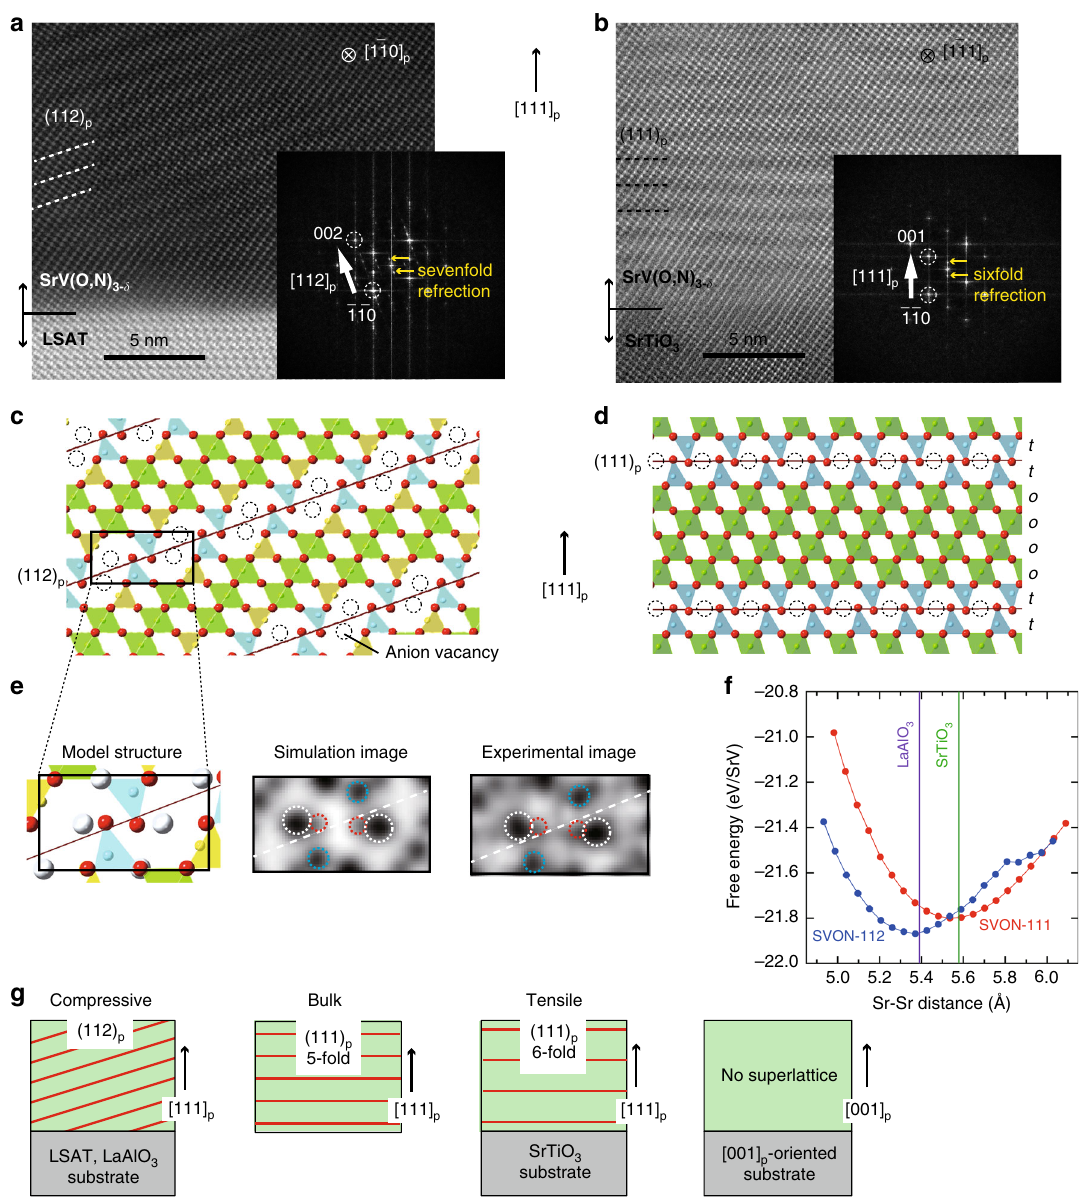
Fig. 4 Strain-induced switching of anion-vacancy layers in [111]-oriented oxynitride thin fi lms. a , b Cross-sectional HAADF image of the nitridized SrVO 3 fi lm on a LSAT (111) and b SrTiO 3 (111) interfaces taken along ½ 1 (cid:1) 10 (cid:2) and their Fourier transform patterns. c , d The corresponding structures with vacancies along ( c ) (112) p and ( d ) (111) p with the oooott sequence (see Fig. 1c for the bulk). Sr atoms are omitt e d. e Experimental and simulated ABF images of the structure in c . f Schematic view of biaxial strain-induced switching of anion-vacancy layers. Red lines represent vacancy layers. g Thermodynamic competition between SVON-111 and -112 as a function of biaxial strain. DFT-calculated free energies of SVON-111 and SVON-112 under fl owing NH 3 (g) at 600 °C, as a function of the Sr − Sr distance. The corresponding cation-cation distances for LaAlO 3 and SrTiO 3 substrates are also